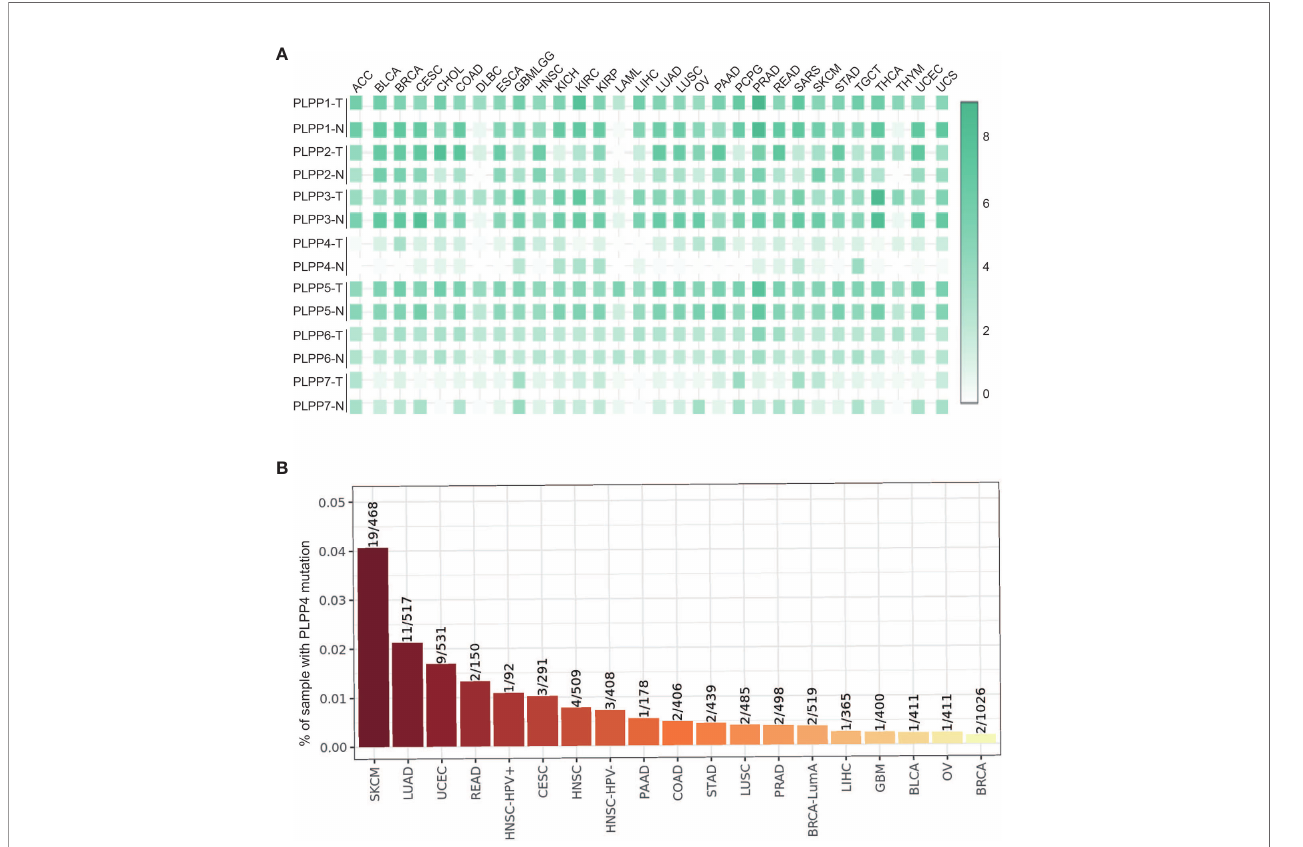
FIGURE 1 | The relative expression status of PLPP4 in cancers. (A) Heatmap: the expression patterns of LPPs in cancer (GEPIA). (B) Genetic alterations of PLPP4 in cancers